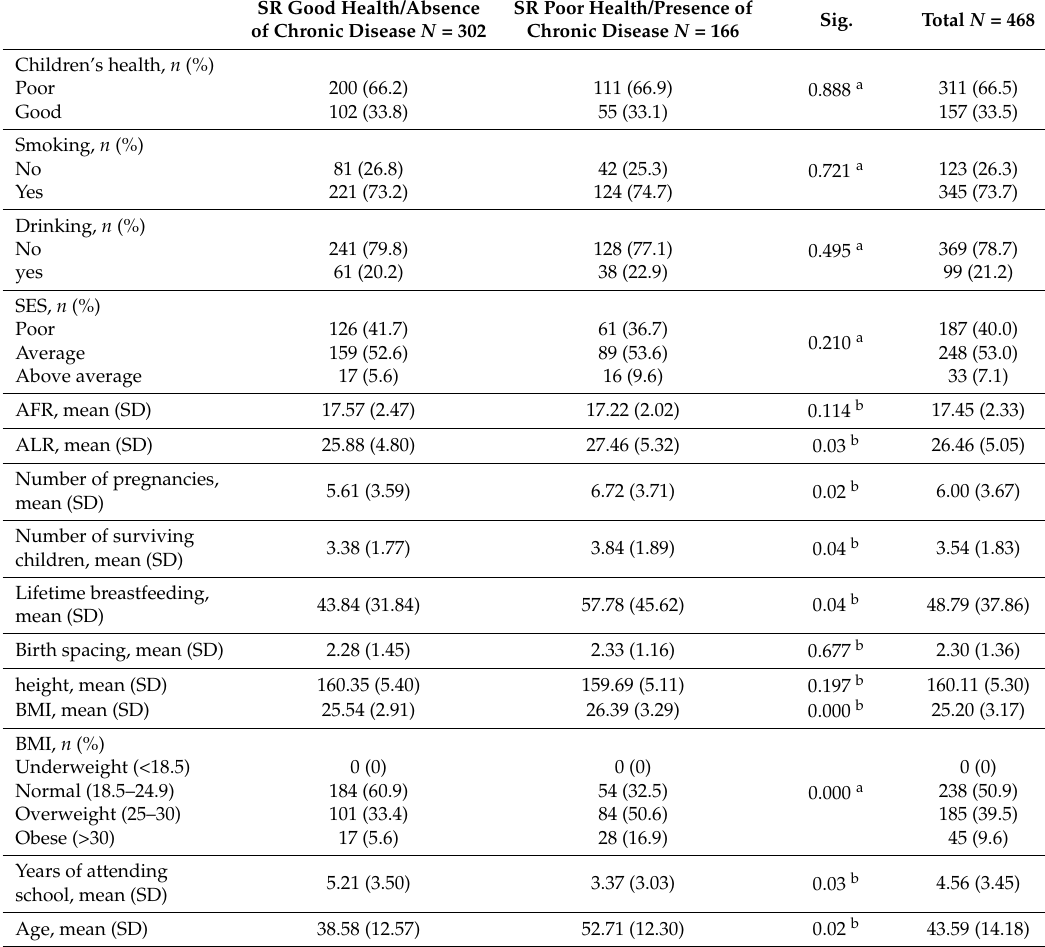
Table 1. Socio-demographic characteristics and health and reproductive variables of Roma women.